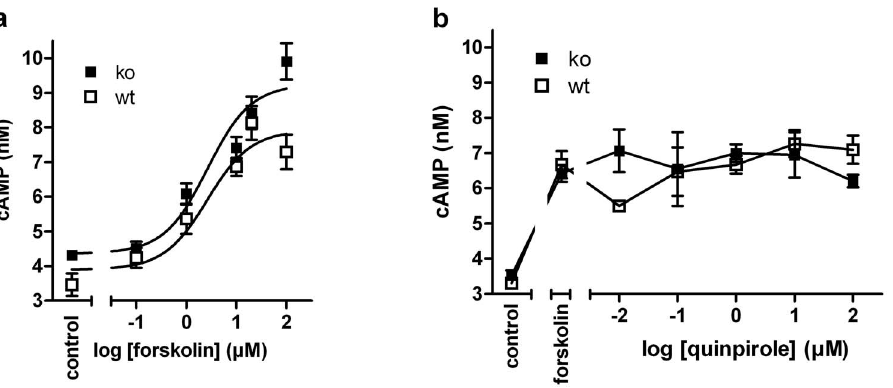
Figure 5. D2R activation does not inhibit forskolin-stimulated cAMP formation in acute striatal samples. ( a ) Forskolin increases cAMP accumulation in acute striatum biopsies from both wt and RGS9-deficient mice with an EC 50 of 2.6 m M (n=4). ( b ) Acute striatum samples prestimulated with 10 m M forskolin were incubated with the selective D2R agonist quinpirole at concentrations from 10 nM to 100 m M. No reduction in cAMP accumulation was detected at sub-micromolar concentrations. Similar results were obtained when 60 m M forskolin were used for prestimulation (data not shown).